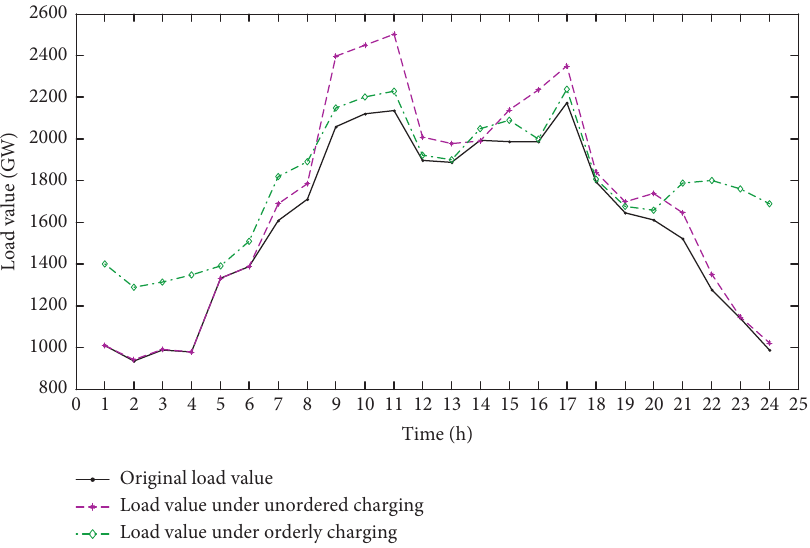
Figure 10: Load curve of power grid under ordered charging behavior.